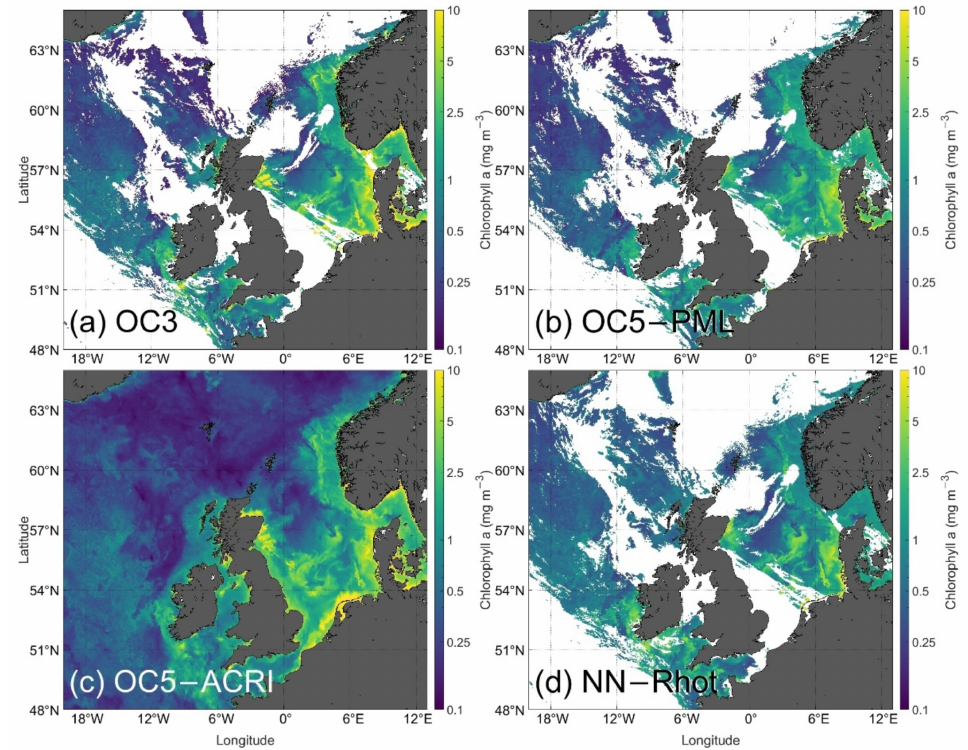
Figure 10. Daily Chlorophyll a surface concentration for the 20 April 2005 from ( a ) OC3, ( b ) OC5-PML, ( c ) OC5-ACRI and ( d ) the median of 10 neural networks using Rhot applied to MODIS Aqua. For ( a , d ), MODIS Aqua images at 12:15, 13:50 and 13:55 were merged. For ( c ), the image was interpolated using +/ − 30 days by ACRI-ST to get a cloud-free